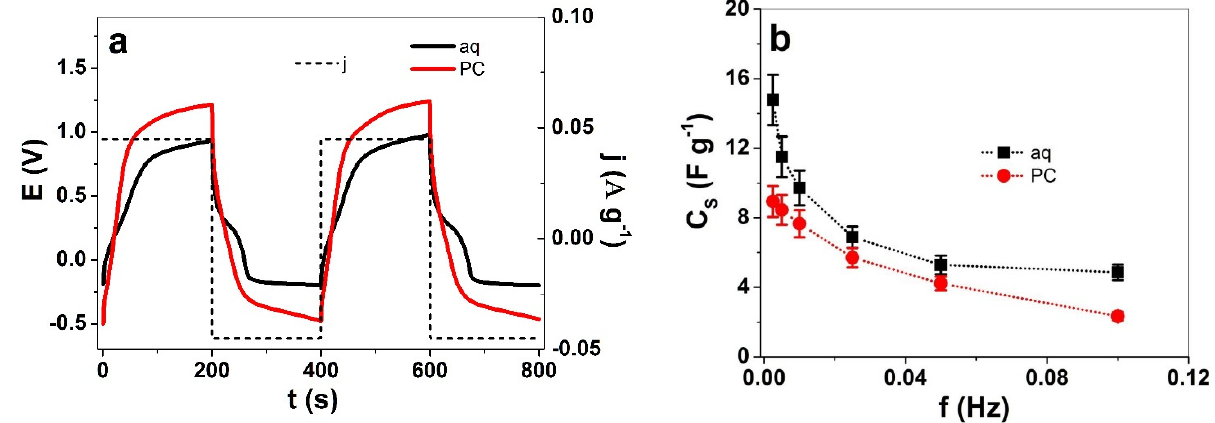
Figure 5. Chronopotentiograms of PIL films in LiTFSI-aq (aq, black curve) and in LiTFSI-PC (PC, red curve) at an applied frequency 0.0025 Hz. ( a ) Potential E to time curves (3rd and 4th cycle) with current densities j (dashed black line) and ( b ) the specific capacitance C s for PIL films in LiTFSI-aq (aq, ∙∙ ■ ∙∙ ) and LiTFSI-PC (PC, ∙∙●∙∙ ) against applied frequencies f (0.0025 Hz to 0.1 Hz).